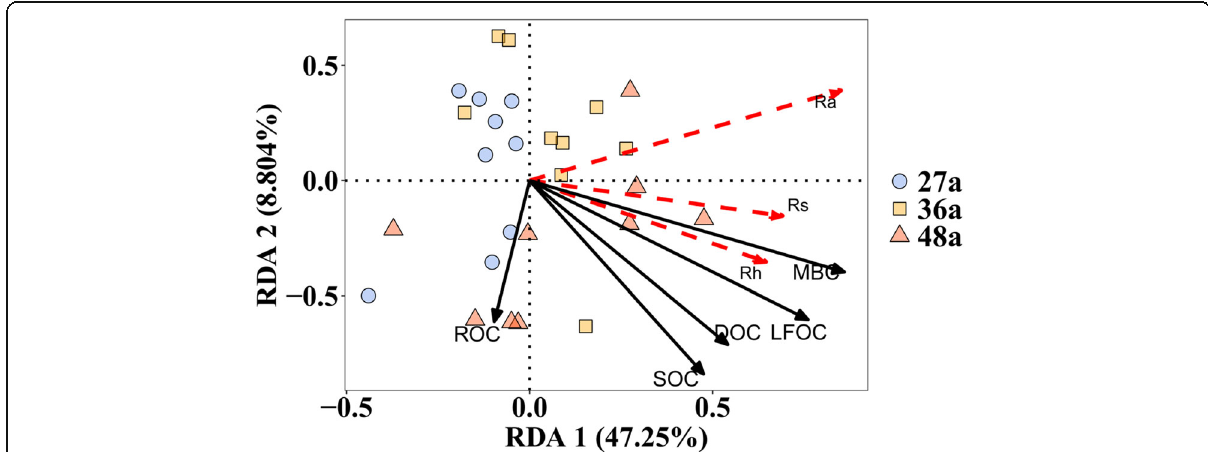
Fig. 7 Redundancy analysis (RDA) to determine the effects of the selected soil organic carbon factor (black arrows) on soil respiration (red arrows). SOC, soil organic carbon; DOC, soil dissolved organic carbon; MBC, microbial biomass carbon; LFOC, light fraction organic carbon; ROC, readily oxidized carbon; Rs, soil respiration; Rh and heterotrophic respiration; Ra, autotrophic respiration. 27a, 27-year-old stand; 36a, 36-year-old stand; 48a, 48-year-old